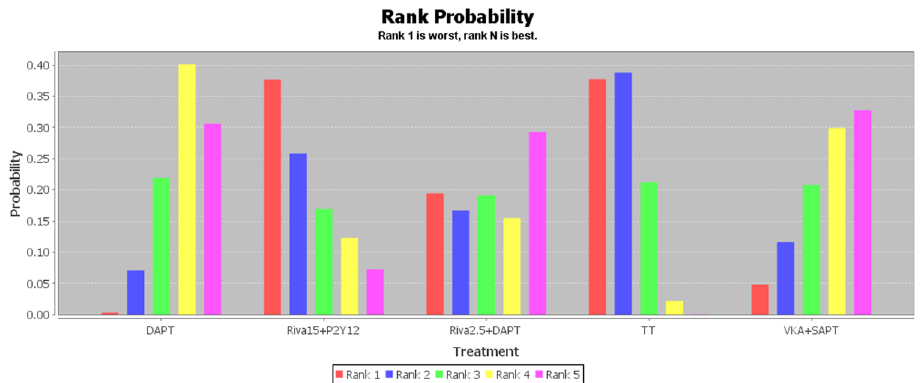
Fig 4. The distribution of major bleeding probabilities of 5 treatments being ranked at possible positions. DAPT, dual-antiplatelet therapy; Riva15+ P2Y 12 , rivaroxaban15 mg/d plus P2Y 12 inhibitor; Riva2.5 + P2Y 12 , rivaroxaban2.5 mg bid plus P2Y 12 inhibitor;TT, triple-antiplatelet therapy; VKA, vitamin K antagonist; SAPT, singleantiplatelettherapy.